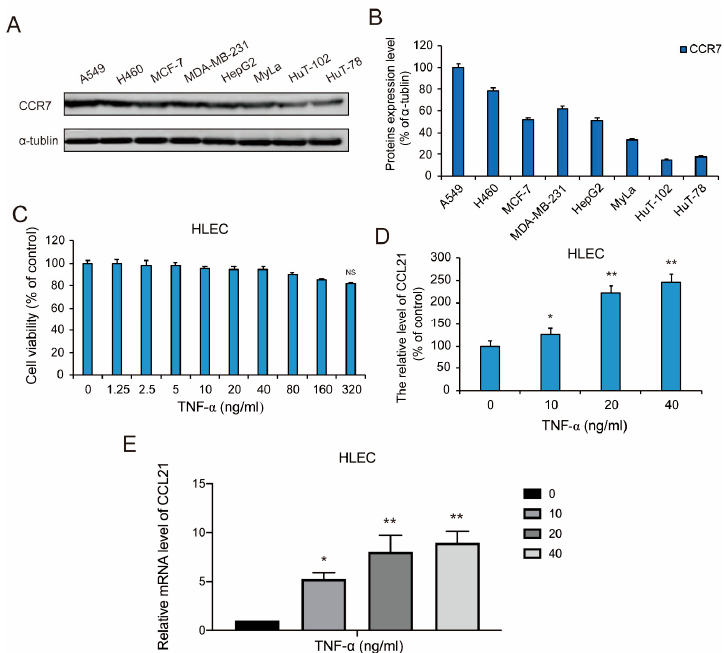
Figure 1. CCR7 is overexpressed in A549 non-small cell lung cancer (NSCLC) cells and TNF- α induced the secretion of CCL21 in human lymphatic endothelial cells (HLEC). ( A,B ) The expression levels